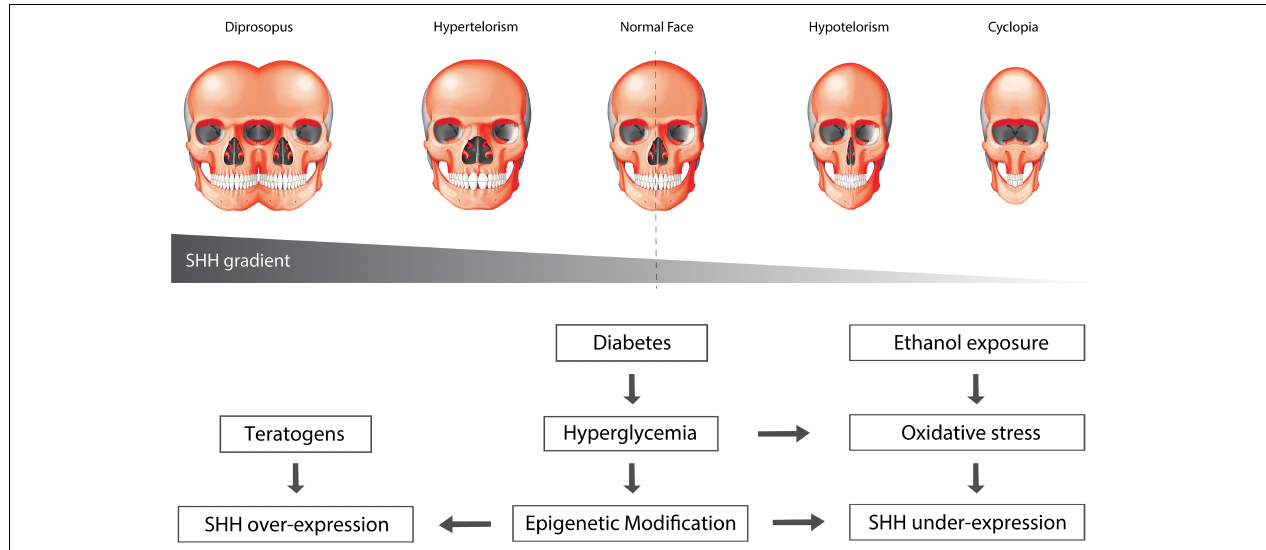
FIGURE 3 | Environmental factors can affect SHH signaling. Oxidative stress and epigenetic modification can alter the levels of SHH signaling. Over-activation of SHH results in widening of the midline, leading to phenotypes such as hypertelorism and diprosopus, or facial duplication. Conversely, suppression of SHH signaling results in narrowing of the midline, leading to hypotelorism and cyclopia, phenotypes that are commonly associated with holoprosencephaly.